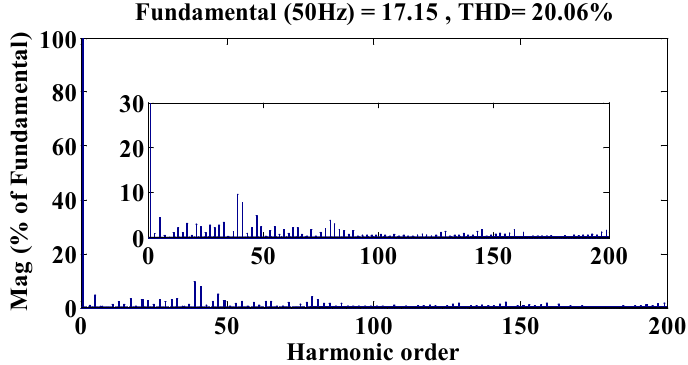
Figure 13. Output waveform for the VFPWM strategy. ( a ) Voltage; ( b ) Current.